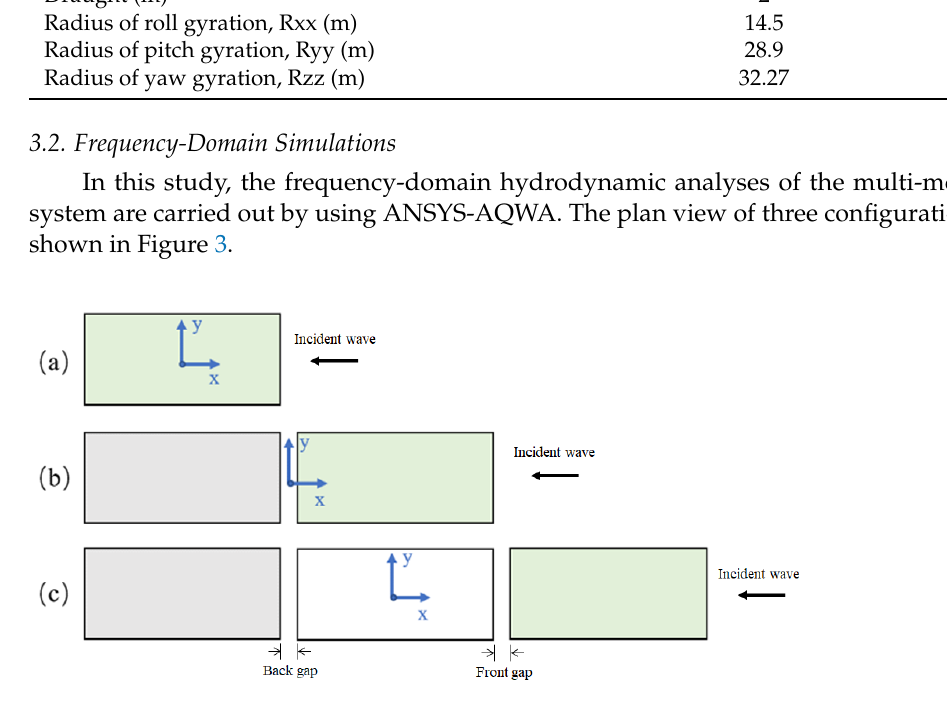
Figure 3. Plan view of three configurations ( a ) 1 module, ( b ) 2 modules, ( c ) 3